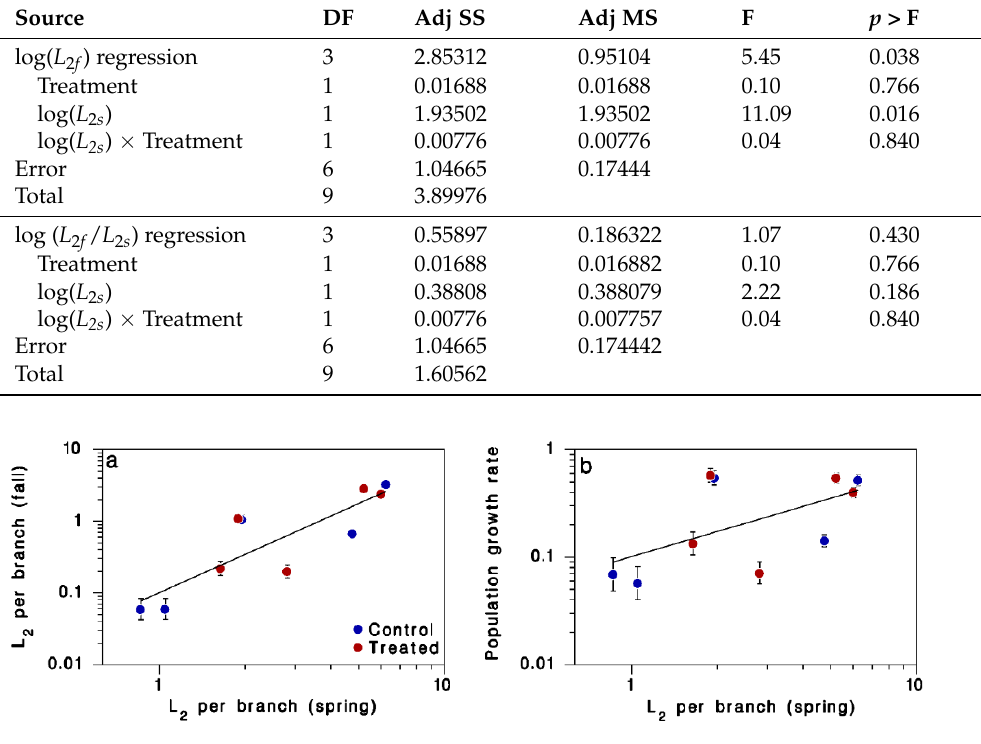
(Figure 7a; R 2 = 0.73; F = 21.29, df = 1,8, p = 0.002; test of residual normality: AD = 0.205, n = 10, p =